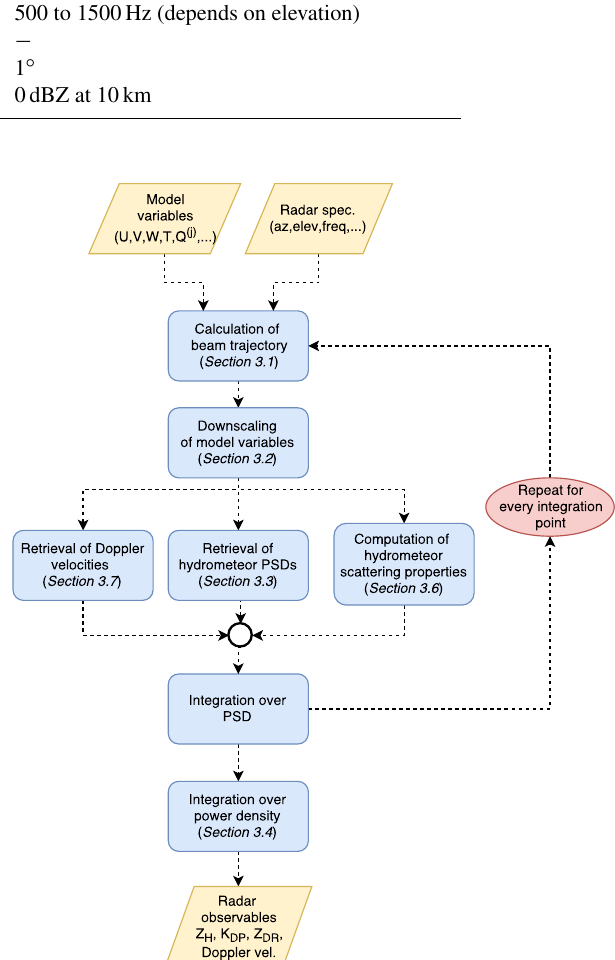
Figure 2. Forward operator